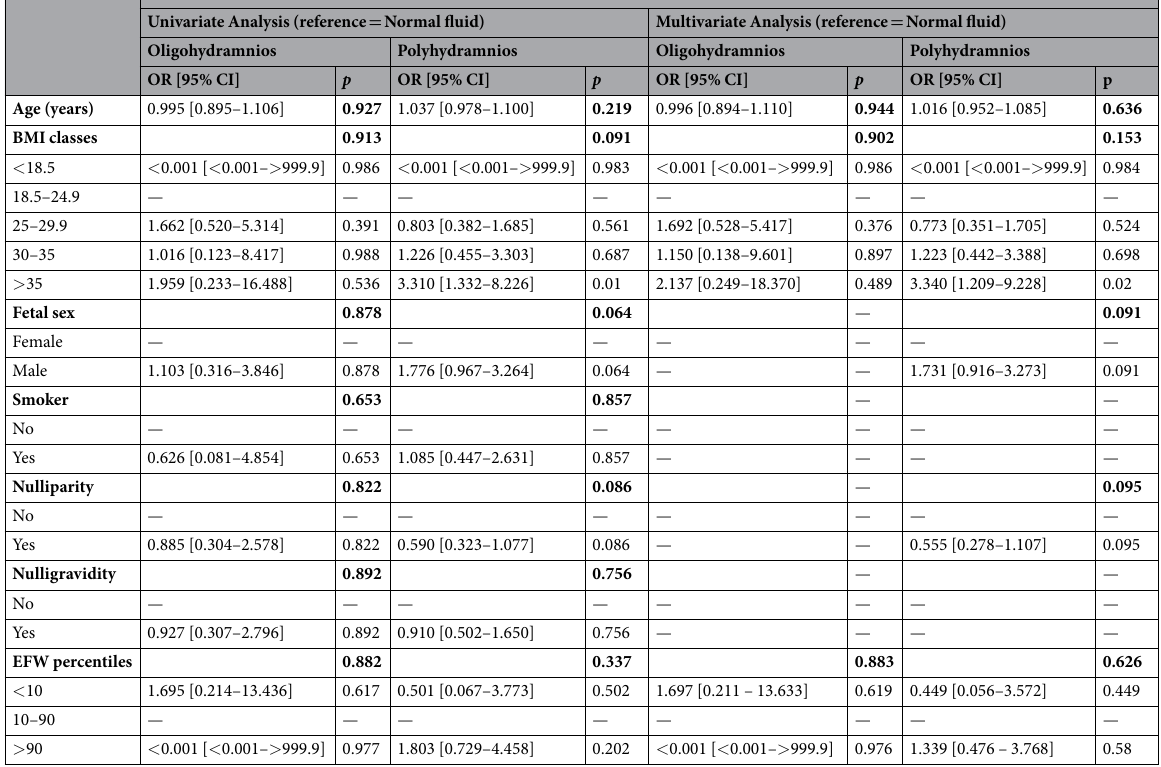
Table 1. Univariate and multivariate logistic regression analysis of the subjective methods (SM) in the second trimester